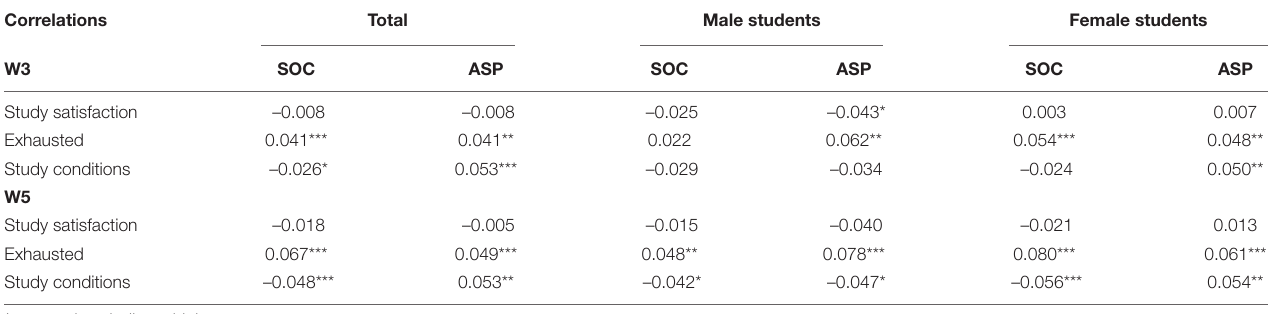
TABLE 5 | Correlations between social congruence (SOC) and aspirational congruence (ASP) and satisfaction measures for all students (Total) and separate for male and female students. Correlations